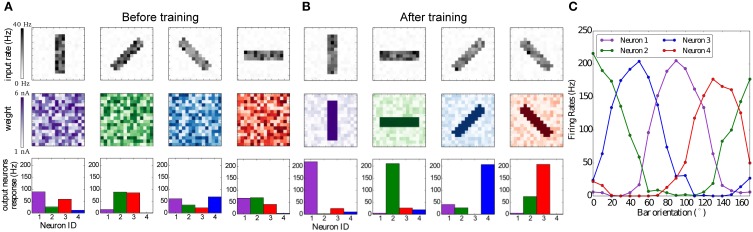
Emergence of orientation selectivity with the BCM learning rule. (A,B): The top row represents the input stimuli bars presented in different orientations, the total firing rate for each stimulus is 1,000 Hz; the middle row shows the weight matrix for the output neurons, with (A) random initial weights and (B) results after the training, where it can be observed that neurons have developed their receptive fields according to the input stimulation; the bottom row shows the firing rates of the output neurons, where each color codes for a different neuron which has learned a preferred orientation. (C) Orientation tuning curves obtained by rotating a horizontal bar counter-clockwise with a step size of 10°C.